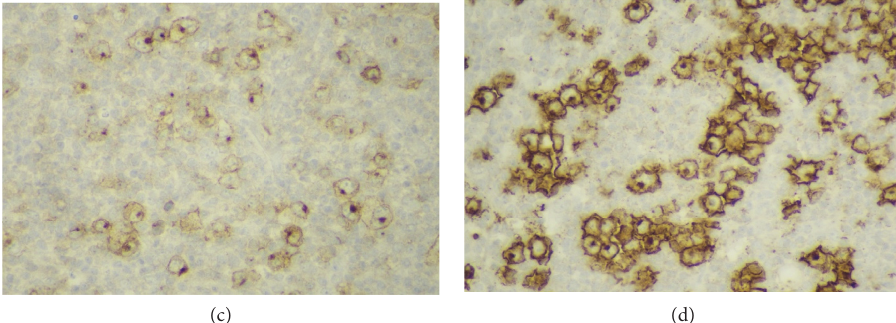
Figure 1: Histology and immunochemistry of axillar lymph node. (a) Lymph node with enlarged capsule and disruptive morphologic structure (hematoxylin-eosin staining). (b) Reed–Sternberg cells (arrow) (hematoxylin-eosin staining). (c) Redd–Sternberg cells showing low affinity to CD30 antibody. (d) Redd–Sternberg cells showing high affinity to CD15 antibody.